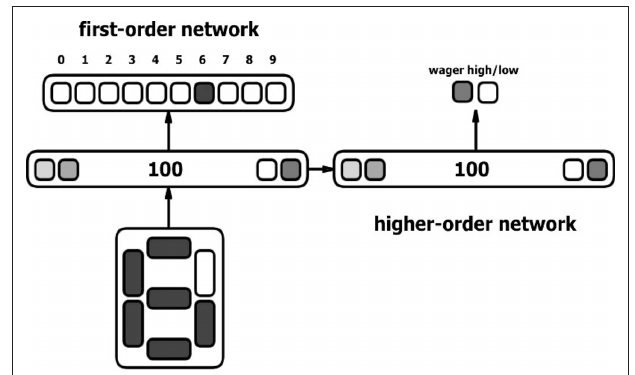
Figure 2 . The task of the higher-order network consisted of wager-